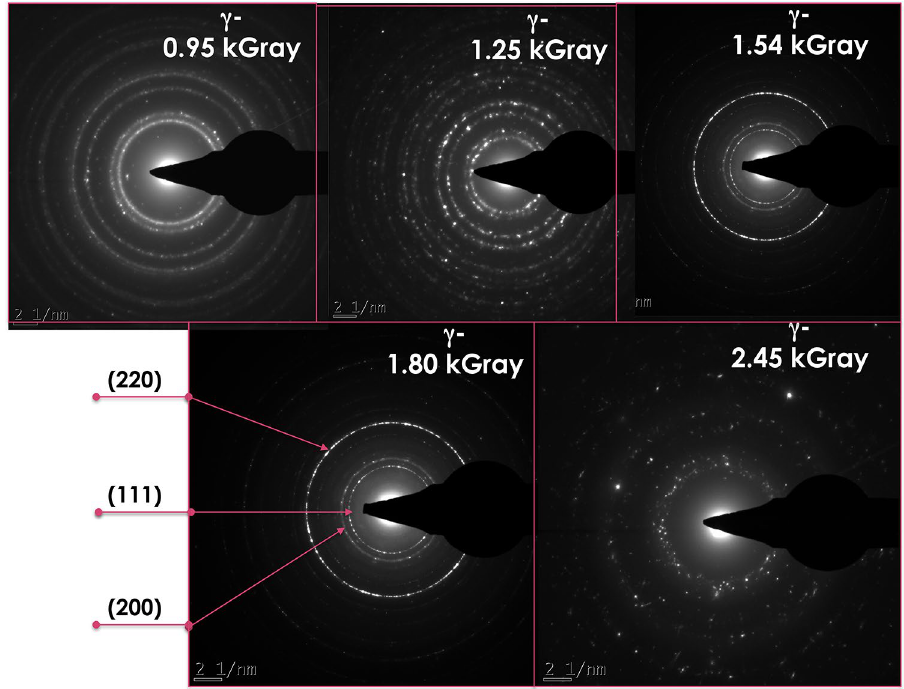
Figure 5. Electron diffraction patterns of the Ag nanoparticles in Ag-C 2 H 6 O 2 radiolized at the various doses of D 1 = 0.9510 3 , D 2 = 1.25 × 10 3 , D 3 = 1.54 × 10 3 , D 4 = 1.80 × 10 3 and D 5 = 2.45 × 10 3